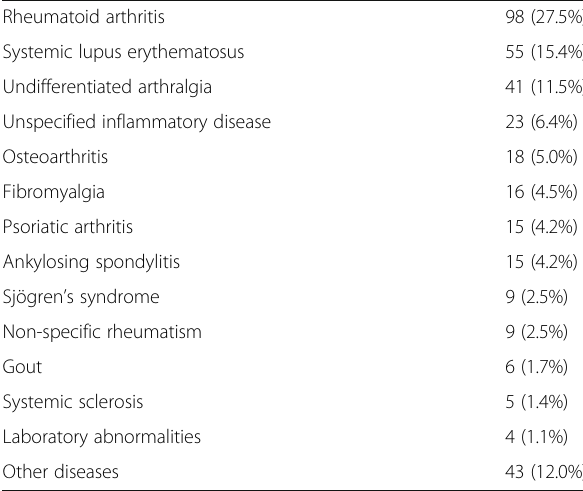
Table 2 Frequency of diagnoses formulated by the general practitioner to justify referral ( n = 357)